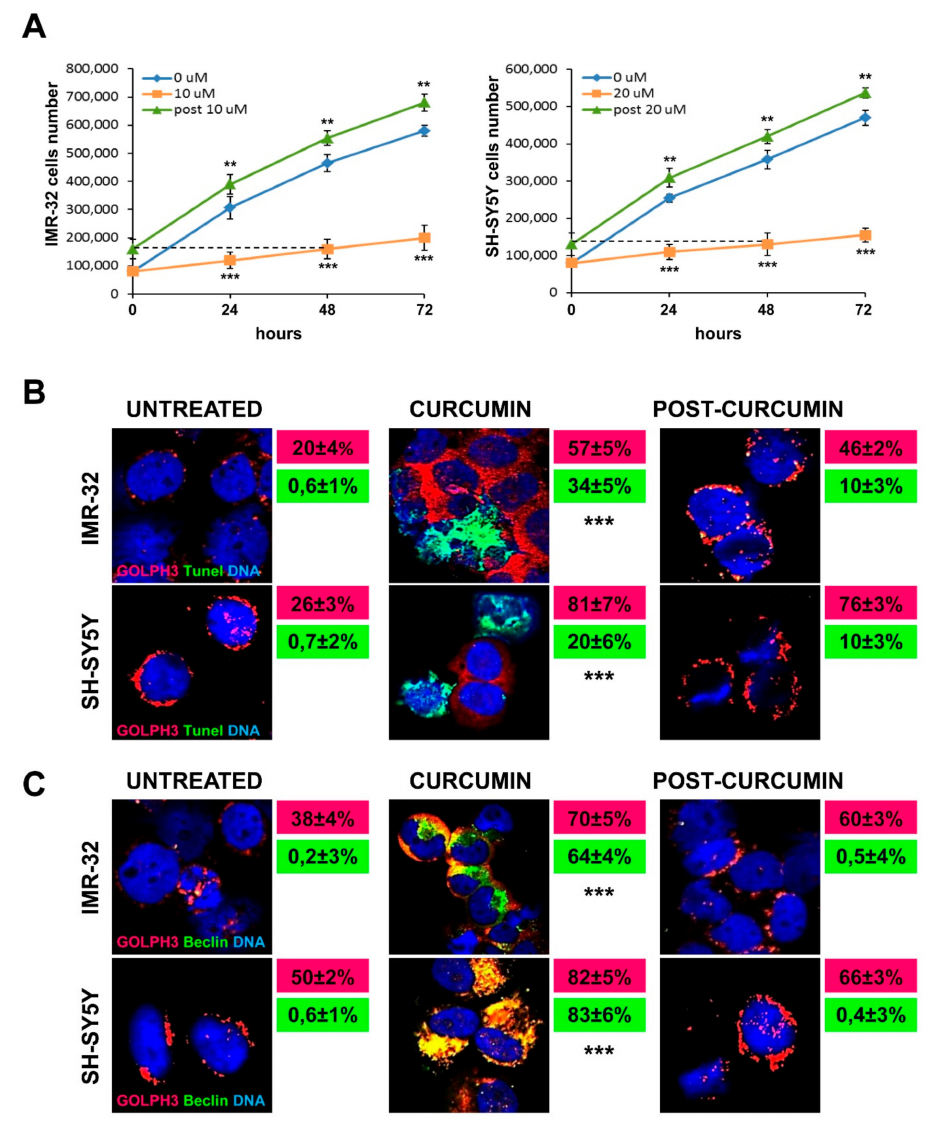
Figure 3. Golgi fragmentation is related to autophagy, not to apoptosis in neuroblastoma cells. ( A ) Comparison among the daily growth rate of untreated cells, of cells treated with curcumin and of cells recovering from 48 h of curcumin treatment, during three days of observation. For the recovery experiment (indicated as post 10 µ M and post 20 µ M) cells were incubated for 48 h with curcumin 10 or 20 µ M and then washed and cultured in drug-free medium for 24, 48 and 72 h. The dashed line indicates the starting point of the recovery experiment observation, corresponding to the 48 h of curcumin treatment. At each harvest point, cells were trypsinized and counted in Trypan blue. Controls (curcumin 0 µ M) were treated with 0.1% DMSO. Data are representative of three independent experiments ± SD. ( B ) Immunofluorescence analysis of IMR-32 and SH-SY5Y cells cultured with 10 or 20 µ M curcumin respectively for 48 h and after 48 h post-Curcumin depletion, using anti-GOLPH3 (red) and TUNEL staining (green) to reveal chromatin condensation. In red and green boxes are reported the percentages of GOLPH3 and tunel positive cells respectively. ( C ) Immunofluorescence analysis of IMR-32 and SH-SY5Y cells using anti-GOLPH3 (red) and anti-Beclin-1 (green). In red and green boxes are reported the percentages of GOLPH3 and Beclin-1 positive cells respectively. Cells were counterstained with DAPI to visualize nuclei (blue). Untreated cells were cultured with 0.1% DMSO. (Magnification 40 × ). Data are representative of three independent experiments ± SD (** p < 0.01; *** p <